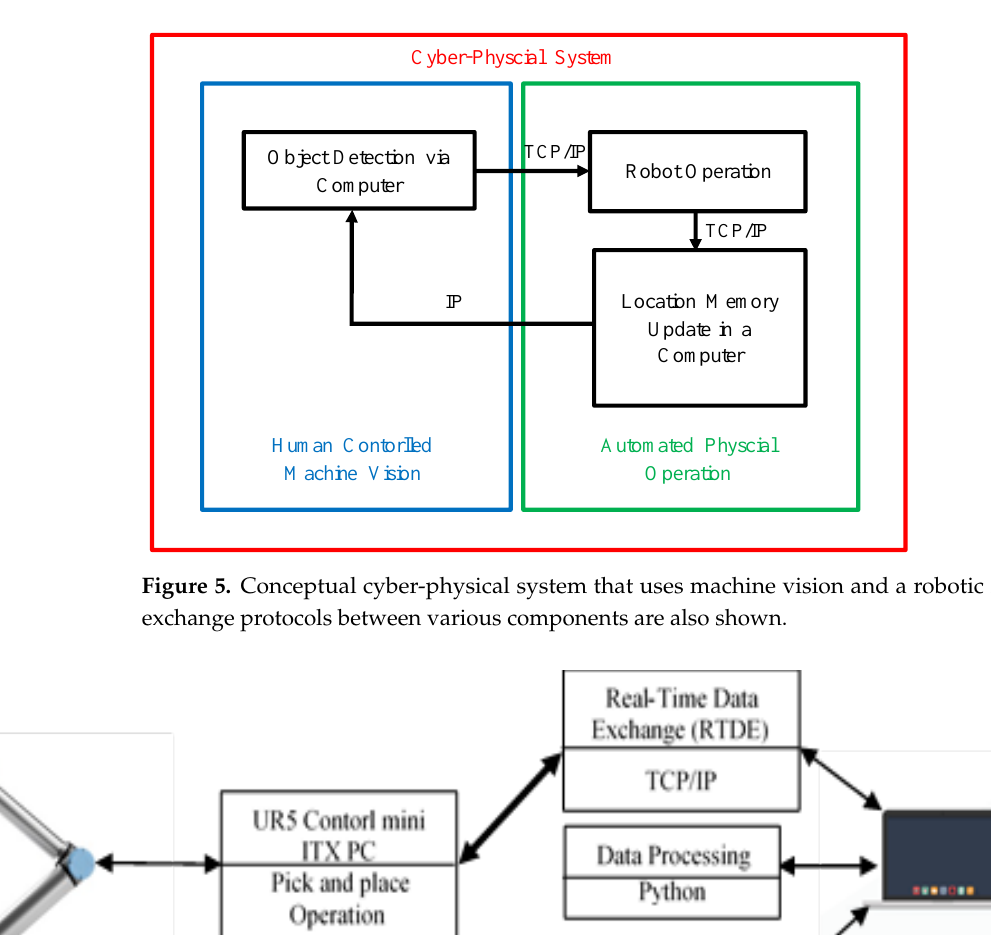
Figure 5. Conceptual cyber-physical system that uses machine vision and a robotic system. Data exchange protocols between various components are also shown.